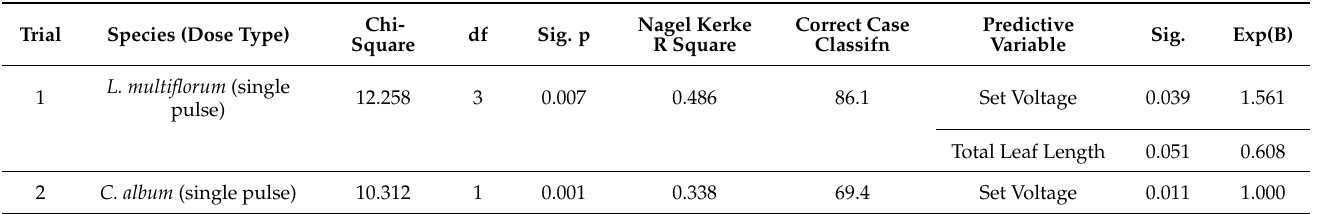
Table 3. Statistical summary table of binary logistic regression analyses of factors significantly predicting the probability of Lolium multiflorum and Chenopodium album weeds dying after receiving single pulse electric